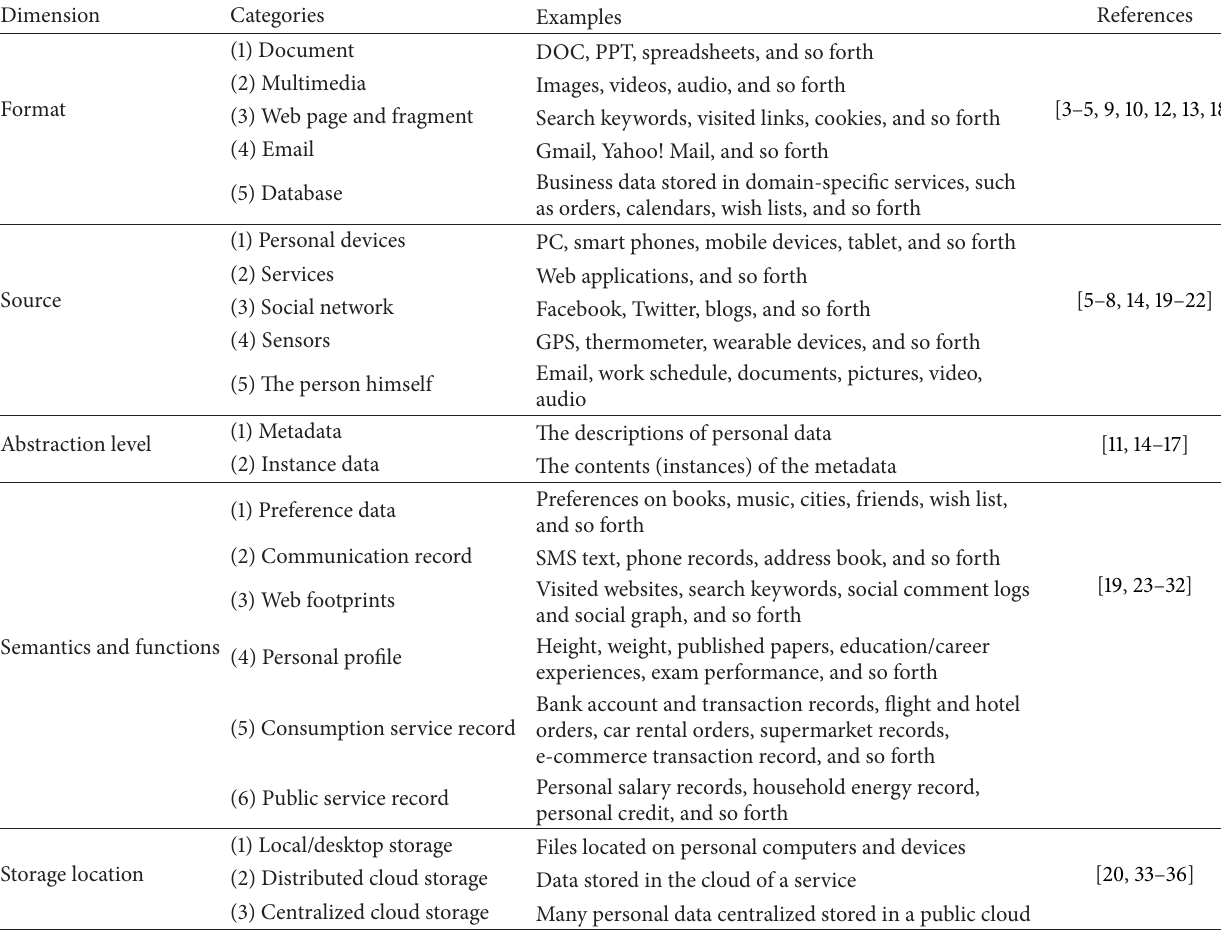
Table 1: Multidimensional classification of personal